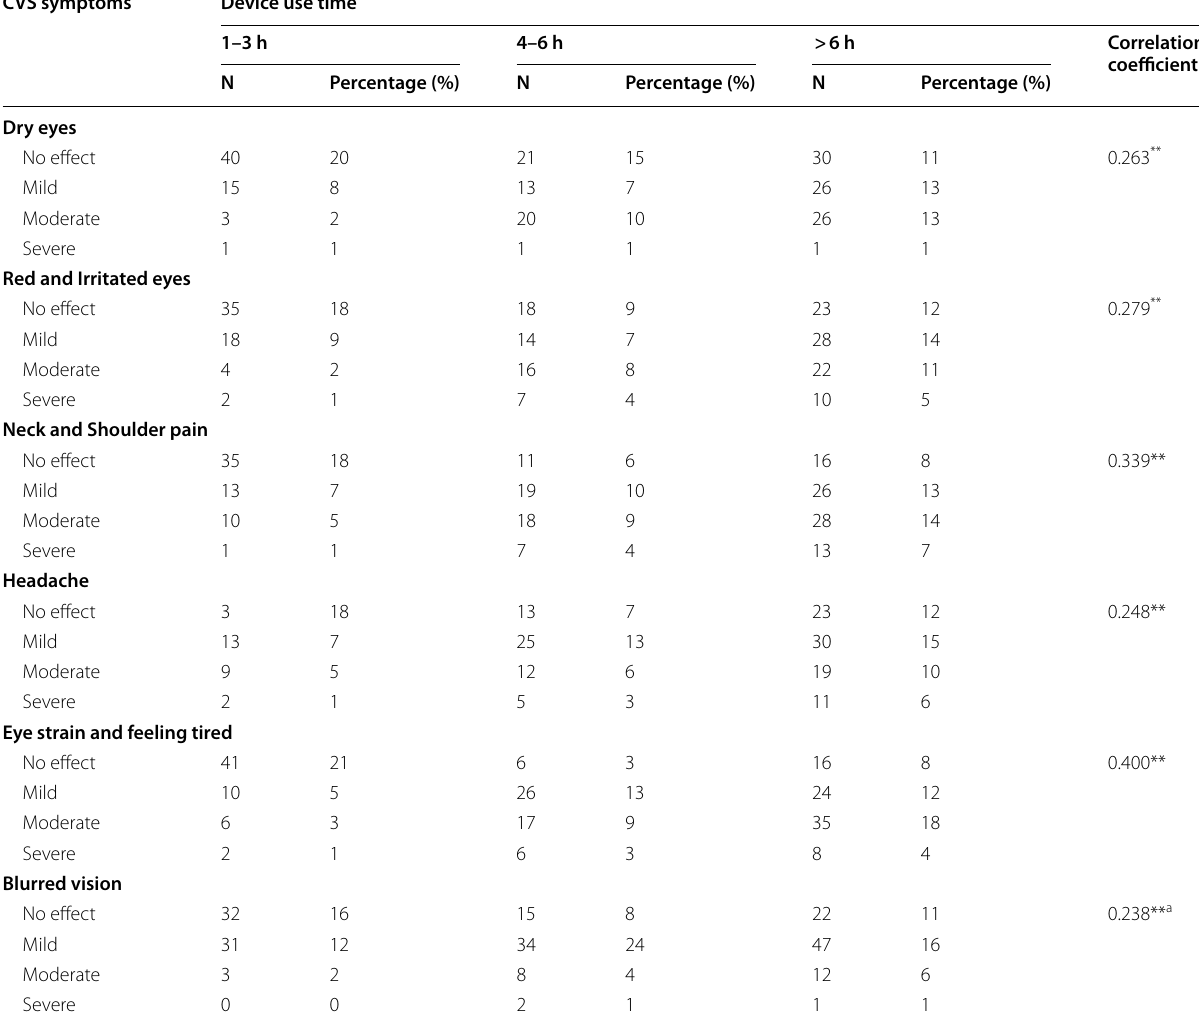
Table 4 CVS symptoms and correlation with the device used CVS